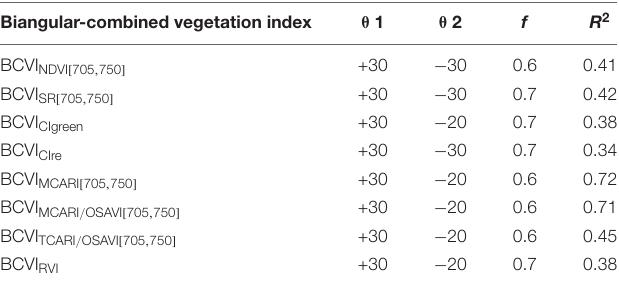
TABLE 6 | The optimal two-angle combination ( θ 1 and θ 2), the adjusting factor f constructed in each best performing biangular-combined vegetation indices (BCVI), and the corresponding maximum R 2 for CCC estimation using field measured